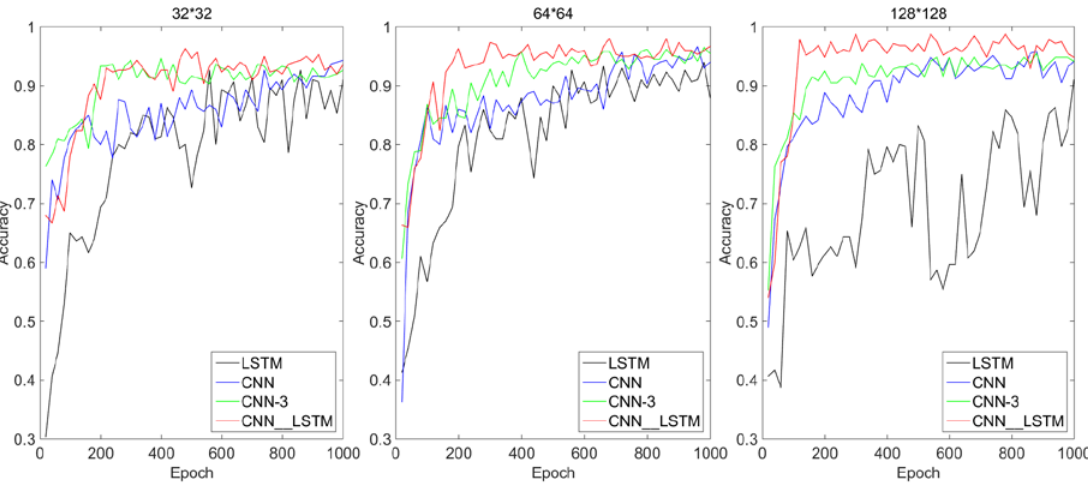
Figure 9. Performance comparison of three algorithms under different input dimensions. Table 1. The recognition accuracy and recognition time of different algorithms under different input sizes.